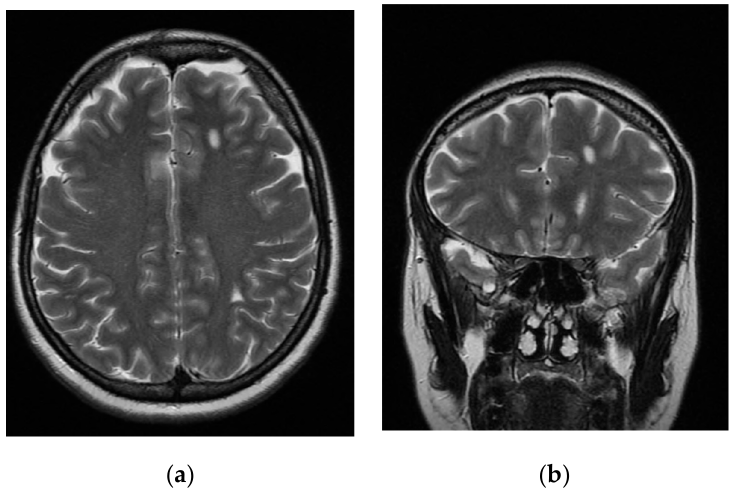
Figure 1. Axial ( a ) and coronal ( b ) fast-spin echo T2-weighted magnetic resonance imaging (MRI) showing two focal gliotic lesions in the subcortical white matter of the left hemisphere in the anterior frontal region ( a , b ) and in the postero-inferior parietal region ( a ).